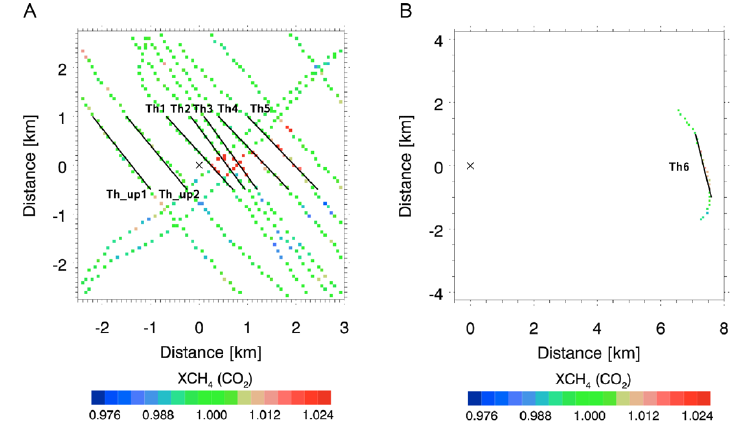
Fig. 12. Boundaries for the integral inversion for near (panel A ) and far (panel B ) part of Theodor Shaft.